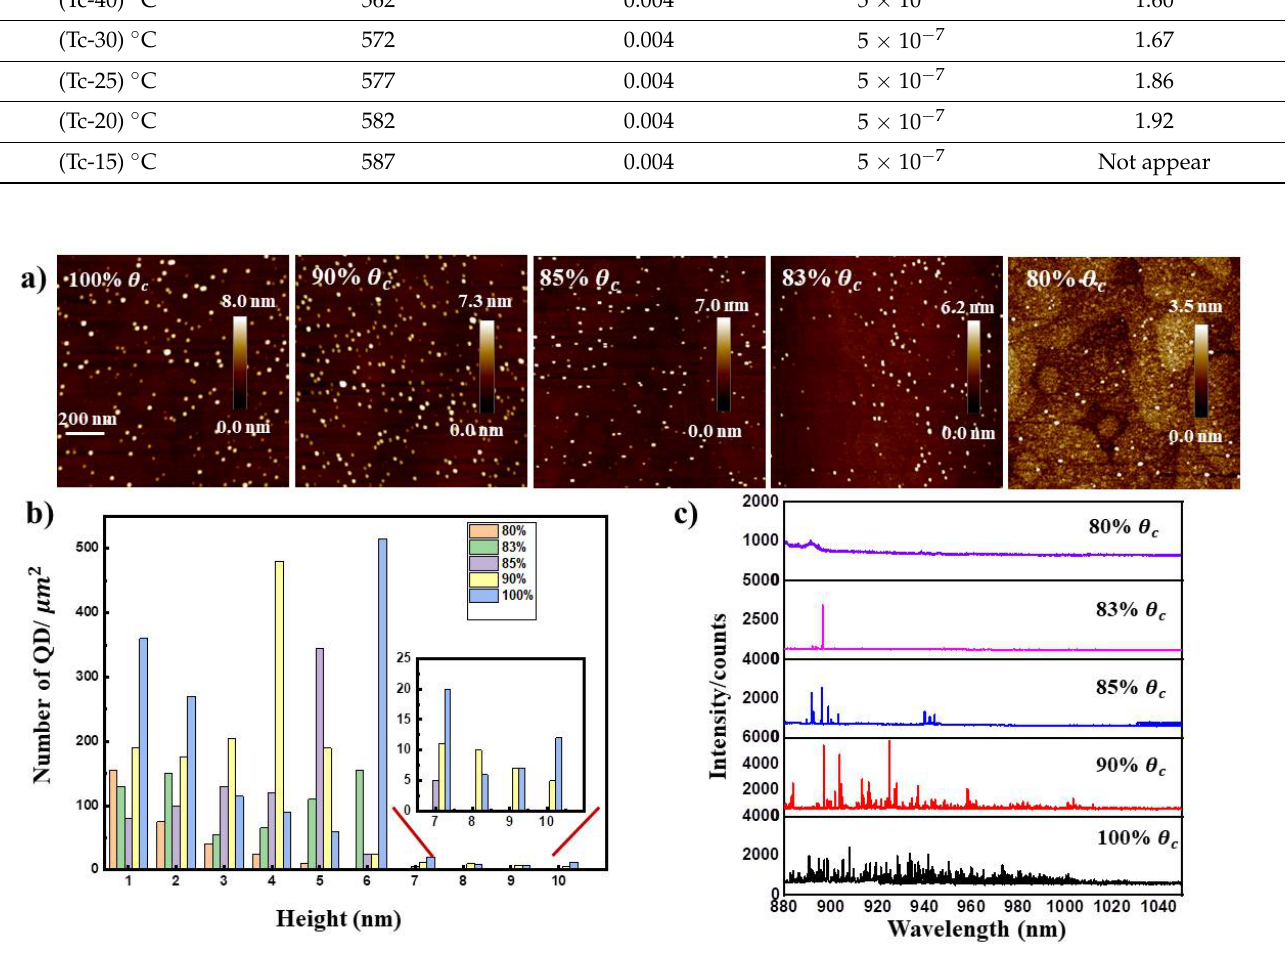
Figure 3. ( a ) Representative of AFM images of 1 µ m × 1 µ m in center part of three-inch wafer with different InAs deposition of 100% θ c , 90% θ c , 85% θ c , 83% θ c , 80% θ c , respectively; ( b ) Statistical height distribution of QDs in the region of 5 µ m × 5 µ m, corresponding ensemble photoluminescence spectra from sample B to F with emission wavelength rage from 880 nm to 1040 nm in ( c ).